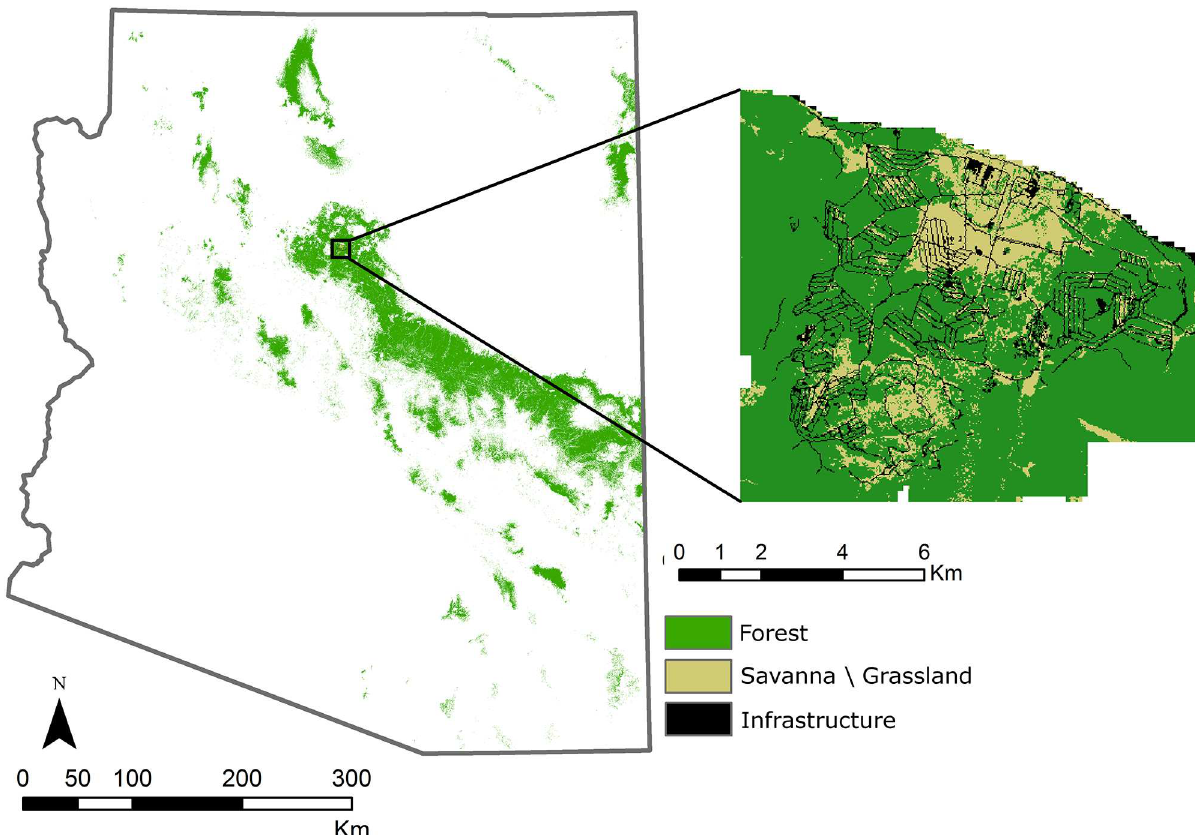
Fig 1. Map of Camp Navajo. The installationis comprisedof ponderosapineforest with some Gambel oak in the understory (dark green) and savanna/grassland(tan) that includeswidely spaced ponderosa pine and Gambel oak. The green area within the border of Arizona shows the distribution of ponderosapine forest within the state. This figure is similar to but not identicalto the originalimage, and is therefore for illustrative purposes